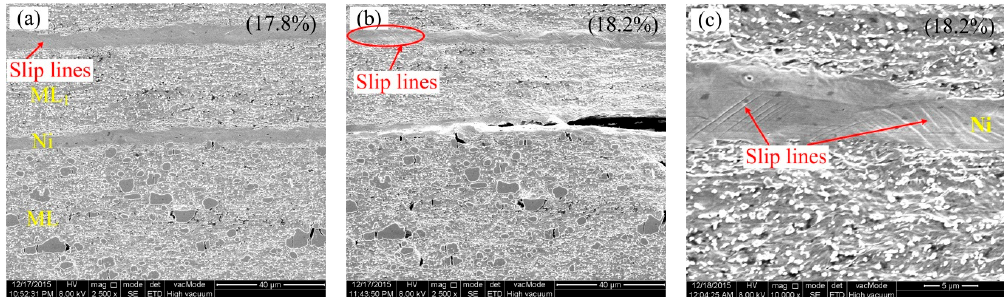
Figure 9. Deformation of the Ni layer observed at various tensile elongations, ( a ) 17.8%, ( b , c ) 18.2%.